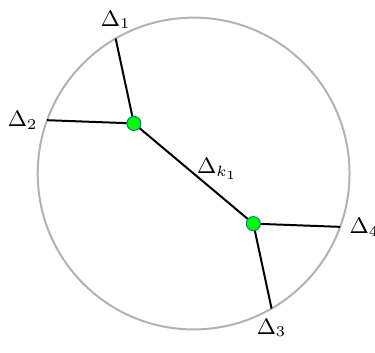
Figure 23 . A canonical 4 -point AdS